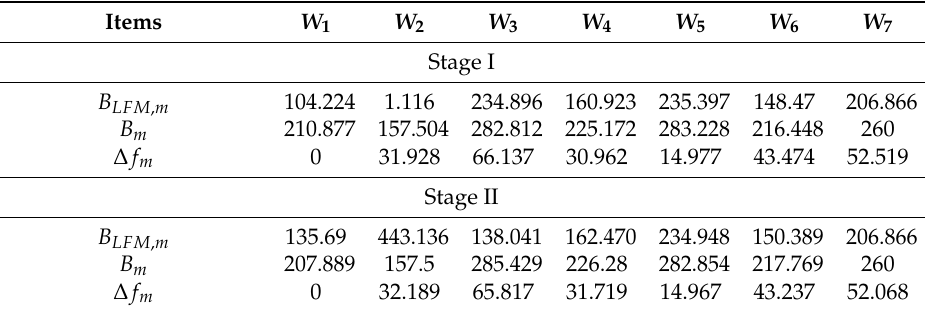
Table 2. Optimized bandwidths and frequency intervals for the one-main-lobe